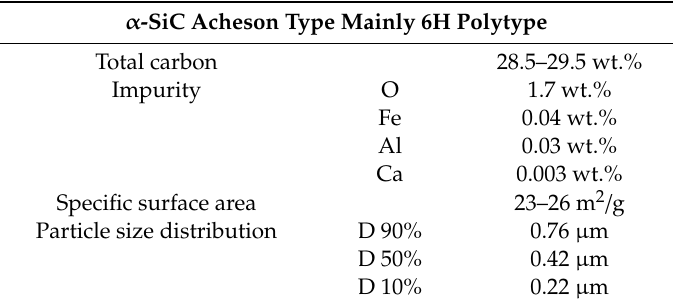
Table 1. SiC powder